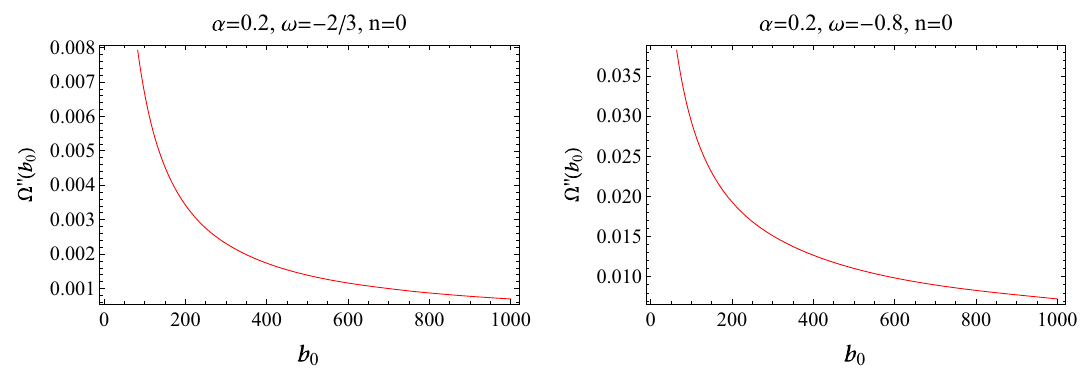
Fig. 3 Stable behavior of thin-shell gravastars with Chaplygin gas model ( n = 0) for β = 0 . 5 = m = Q with different values of ω